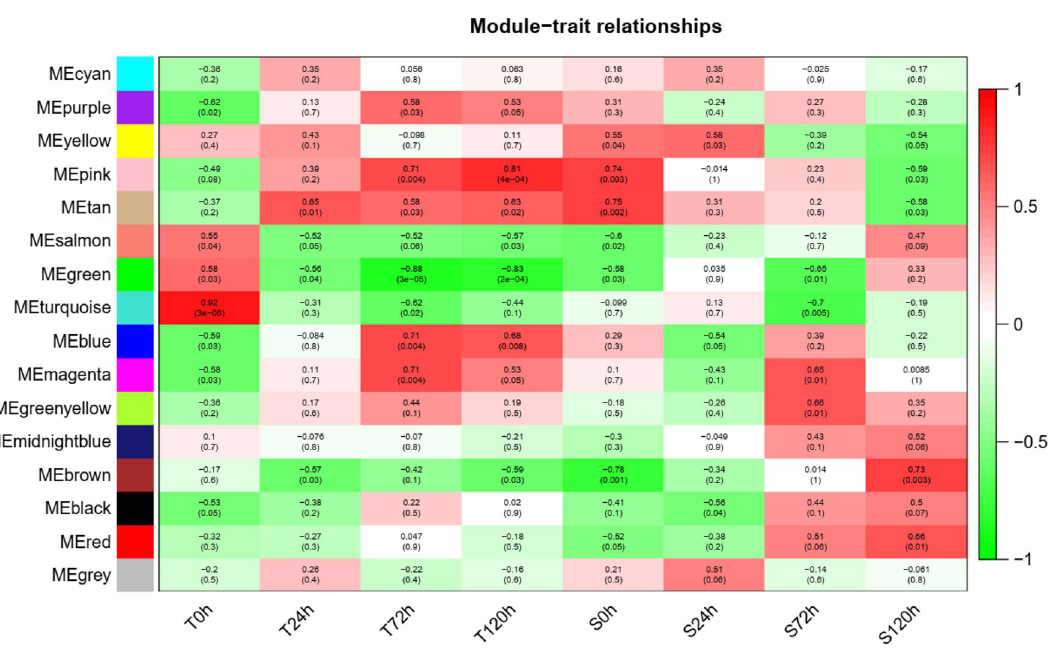
Figure 7. Module-trait correlation of G. hirsutum in response to V. dahliae fungus infection at specific time